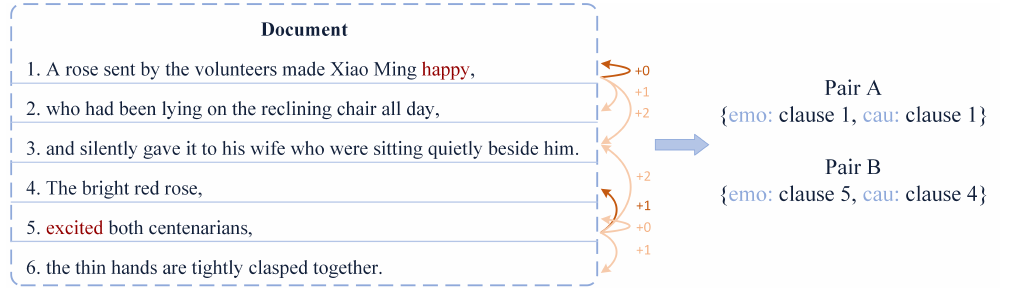
Figure 1. Document instances in the